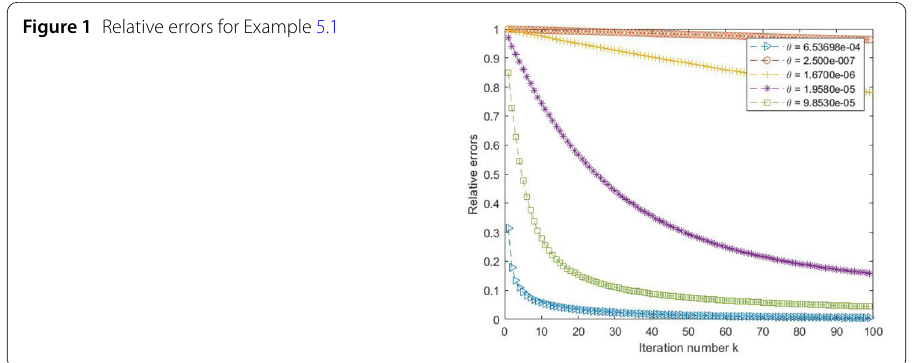
Figure 1 Relative errors for Example